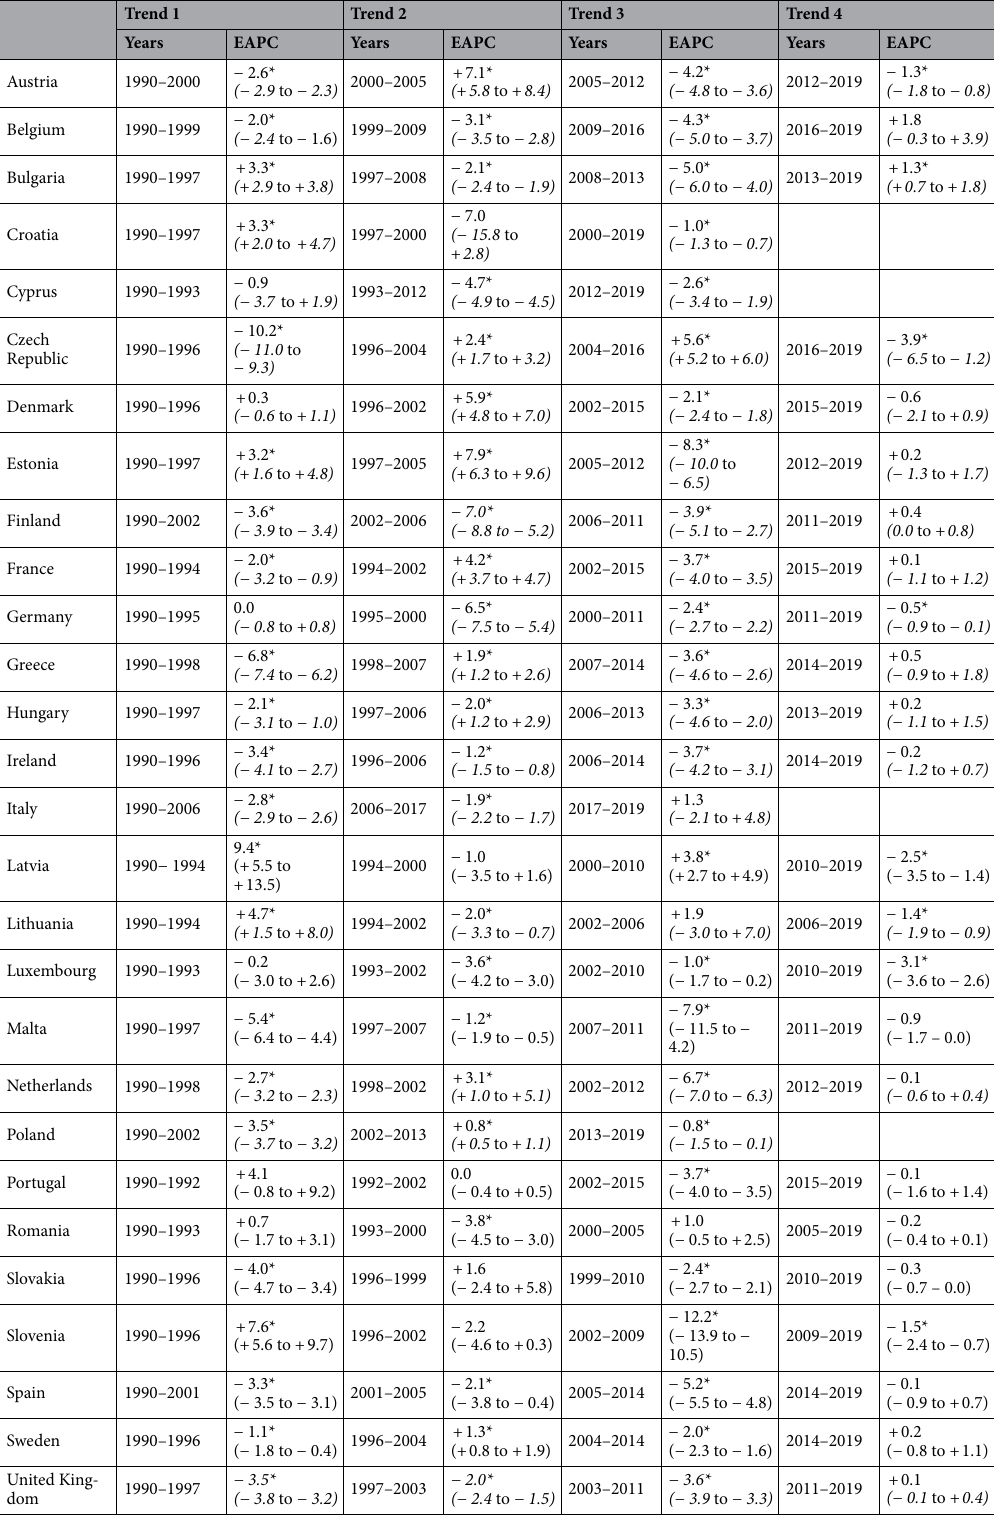
Table 2. Joinpoint analysis for age-standardised mortality rates (ASMRs) per 100,000 population resulting directly from type 2 diabetes mellitus (T2DM) in females. Italic values indicates 95% confidence intervals. EAPC indicates estimated annual percentage change with 95% confidence intervals in brackets. *Significantly different from 0 (P <